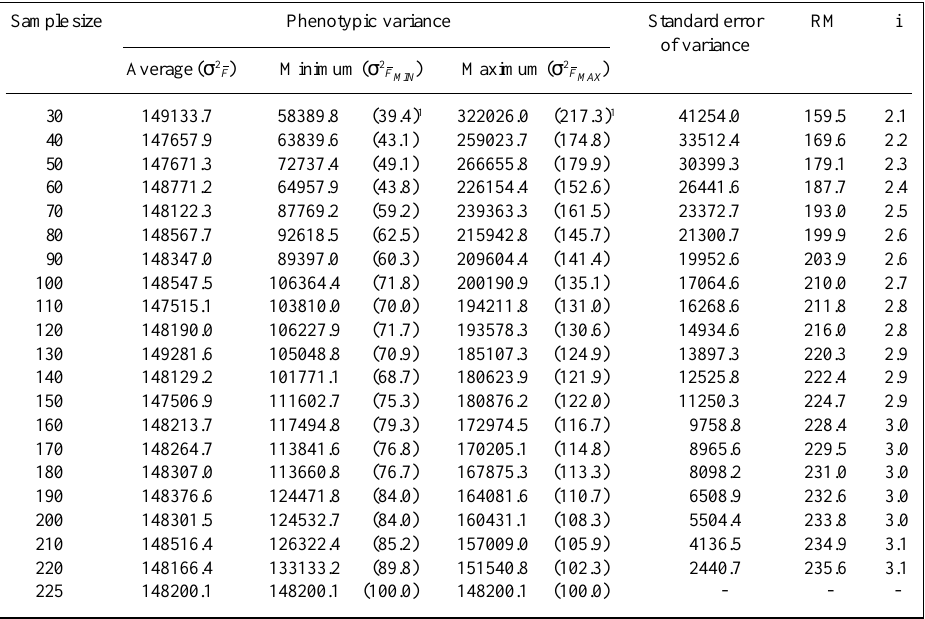
Table II - Phenotypic variances (average, minimum and maximum) for grain yield (kg/ha) for different sample sizes. The standard error of the variance, range of the means (RM) and the standardized selection intensity (i) are also shown for the F 2:4 and F 3:5 families from the Carioca-Mg x H4